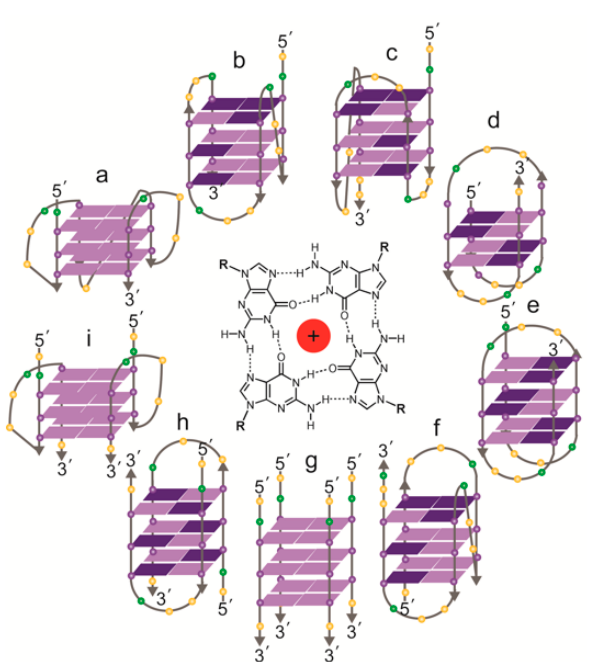
Figure 3. Topologies of solved structures of human telomeric G-quadruplexes, either intramolecular ( a – f ) or intermolecular ( g – i ). Centre: a G-quartet, comprising four guanines, stabilized by a central cation. ( a ) Crystal structure of AG 3 (T 2 AG 3 ) 3 in K + ( parallel monomer ) [84]; ( b ) NMR structure of TAG 3 (T 2 AG 3 ) 3 in K + ( hybrid form 1 ) [85]; ( c ) NMR structure of TAG 3 (T 2 AG 3 ) 3 TT or TTAG 3 (T 2 AG 3 ) 3 TT